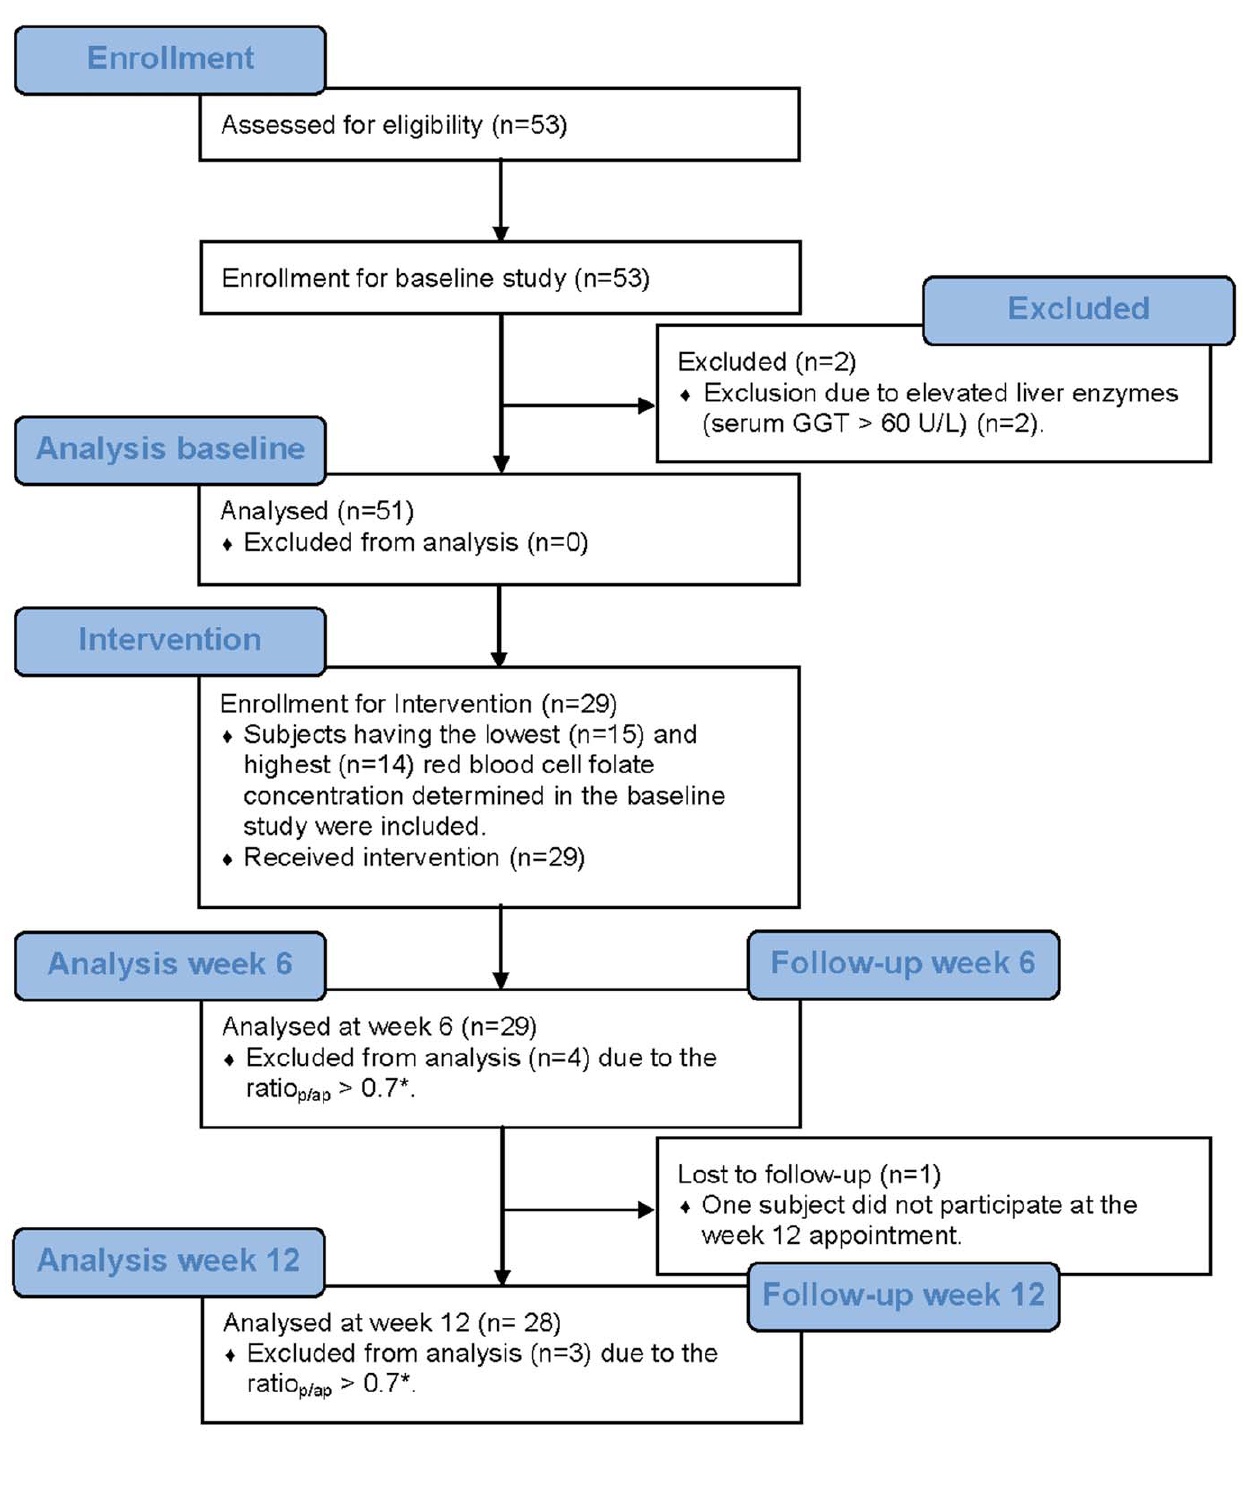
Figure 1. Flow chart of study selection process.